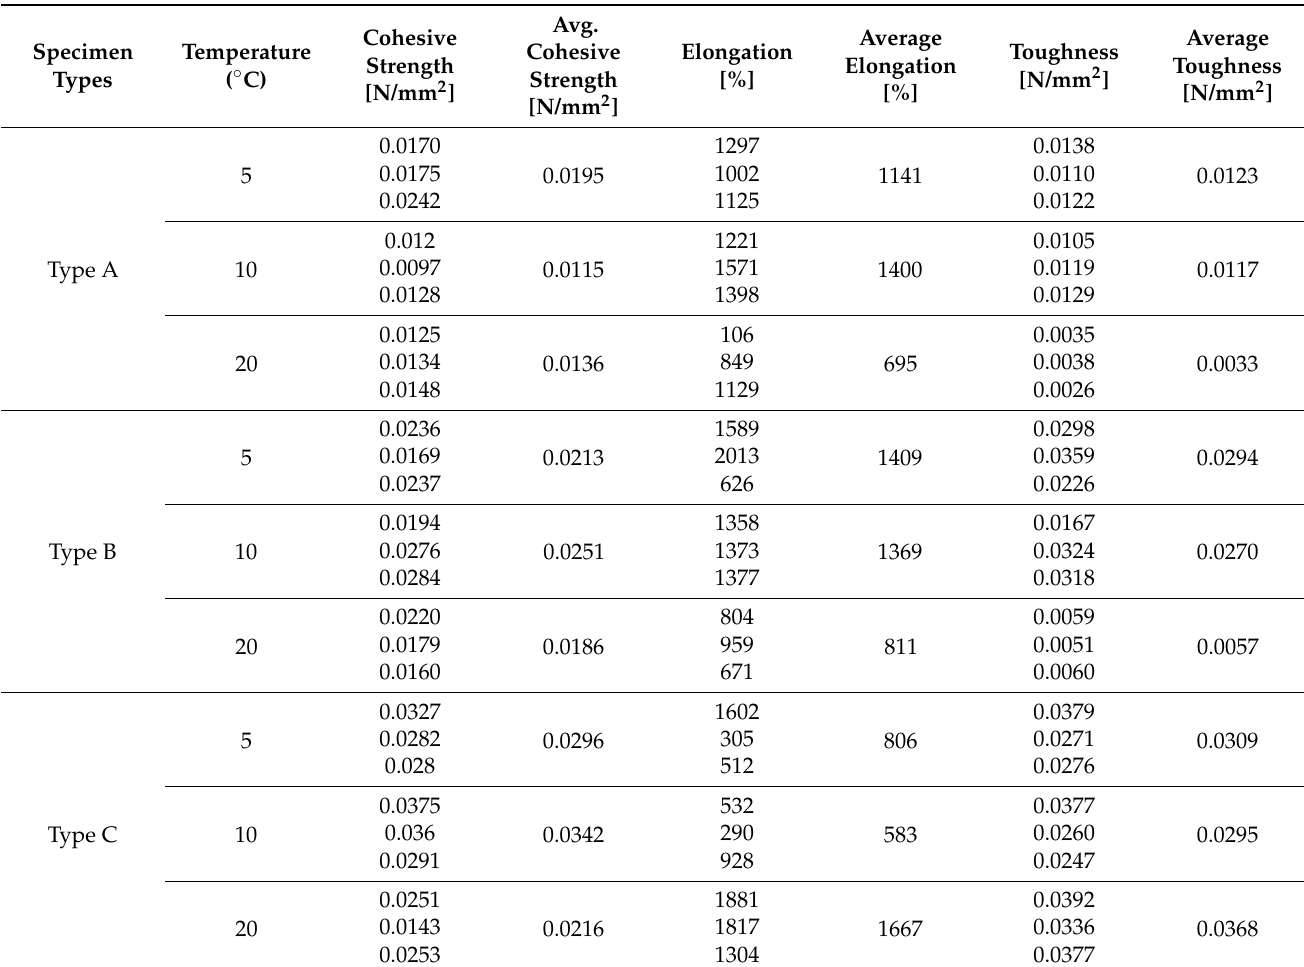
Table 3. Measurement result based on specimen types (2 mm